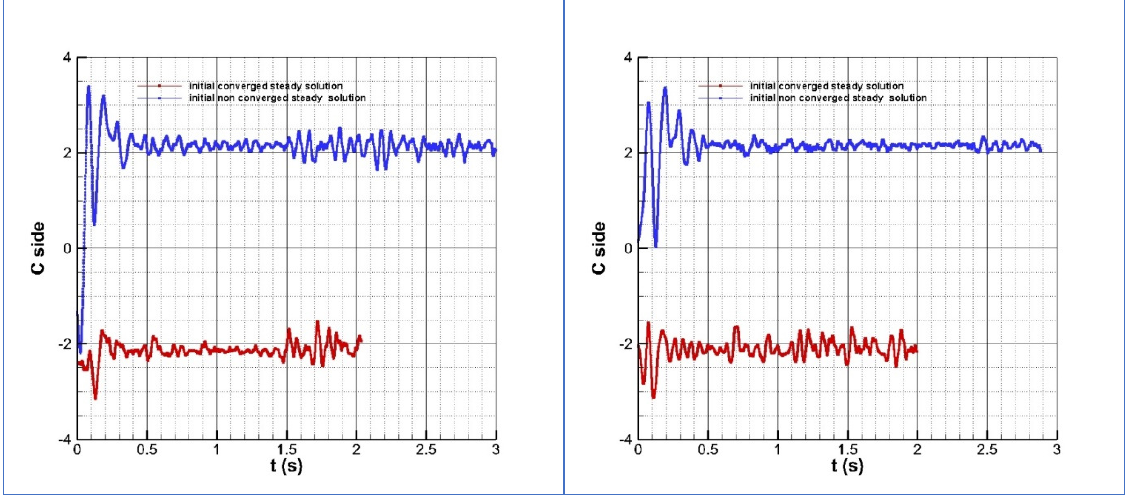
Figure 6. Time convergence history for the side force coefficient at Mach = 0.2, Re = 2 × 10 6 and angle of attack α = 45 deg. ( Left) : Orientation angle Φ = 0 deg. ( Right ): Orientation angle Φ = 270 deg. Reference structured grid.